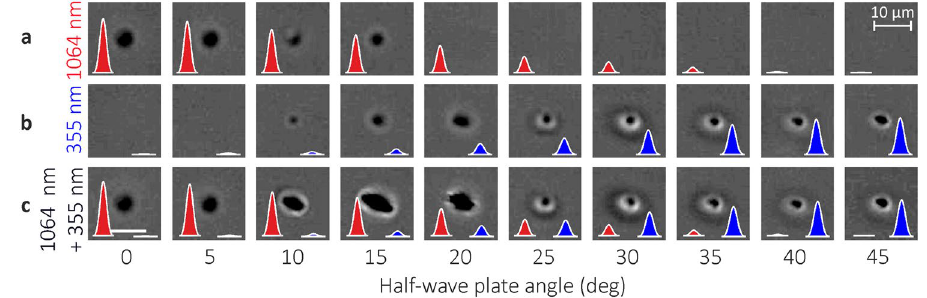
Figure 1. Laser-induced intra-volume modifications in sapphire. Transverse-plane optical microscope images of laser-induced intra-volume modifications in the sapphire wafer. ( a ) Single laser pulse modification at the wavelength of λ = 1064 nm; ( b ) single laser pulse modification at the wavelength of λ = 355 nm; ( c ) dual- wavelength double-pulse induced modification at wavelengths of λ = 1064 nm and λ = 355 nm with the delay of Δ t ≈ 0.1 ns between pulses (UV prior IR). The inserted red and blue laser pulses graphically represent the decay of IR and growth of UV laser pulse energies with the increase of the orientation angle of the